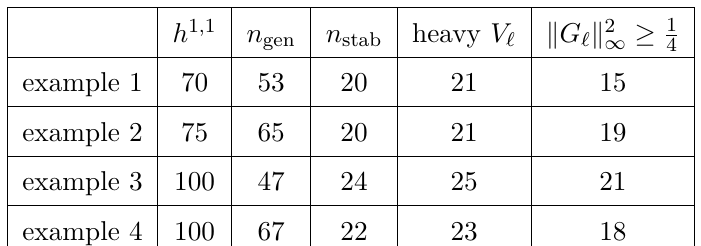
Table 1 . In this table we summarize the statistics of our study of geometries with large h 1 , 1 : the number n indicates the number of generators we managed to compute for the Kähler cone; the gen number n gives the number of moduli in which the sl(2)-approximated Hodge star ? stab in the strict asymptotic regime we chose; the next column specifies the number of sl(2)-eigenspaces V ‘ which are heavy asymptotically; the last column indicates how many out of these heavy V ‘ have a boundary Hodge norm bounded from below by at least 1 / 4